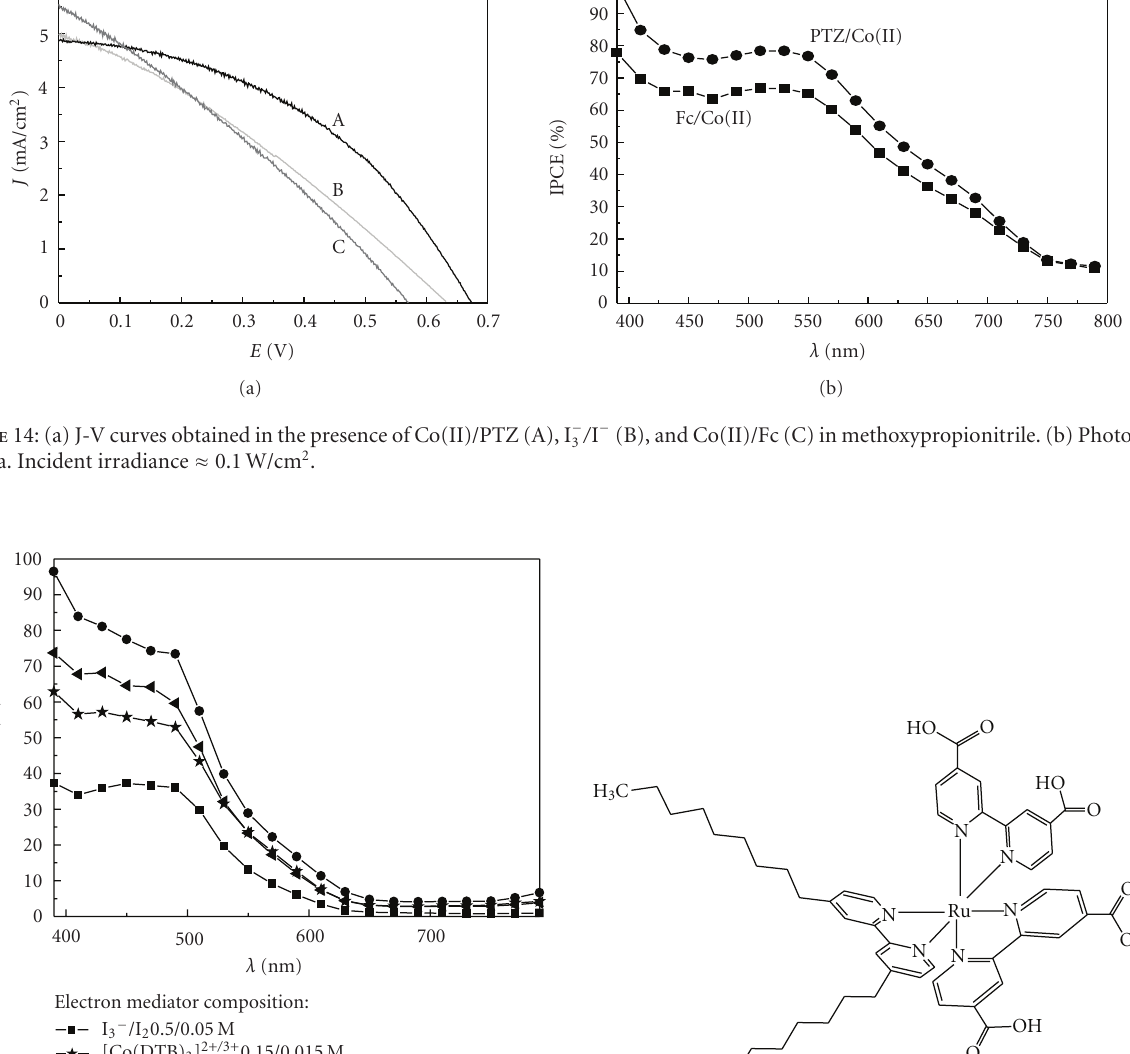
obtained in the presence di ff erent electron transfer mediators. 2